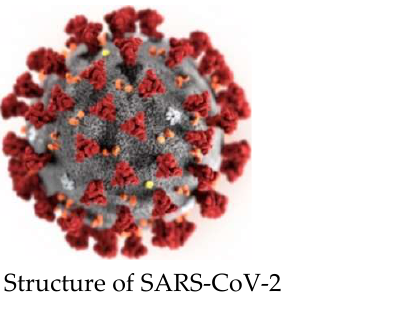
Figure 1. Coronavirus SARS-CoV-2 (size 50–200 nanometers) [1].